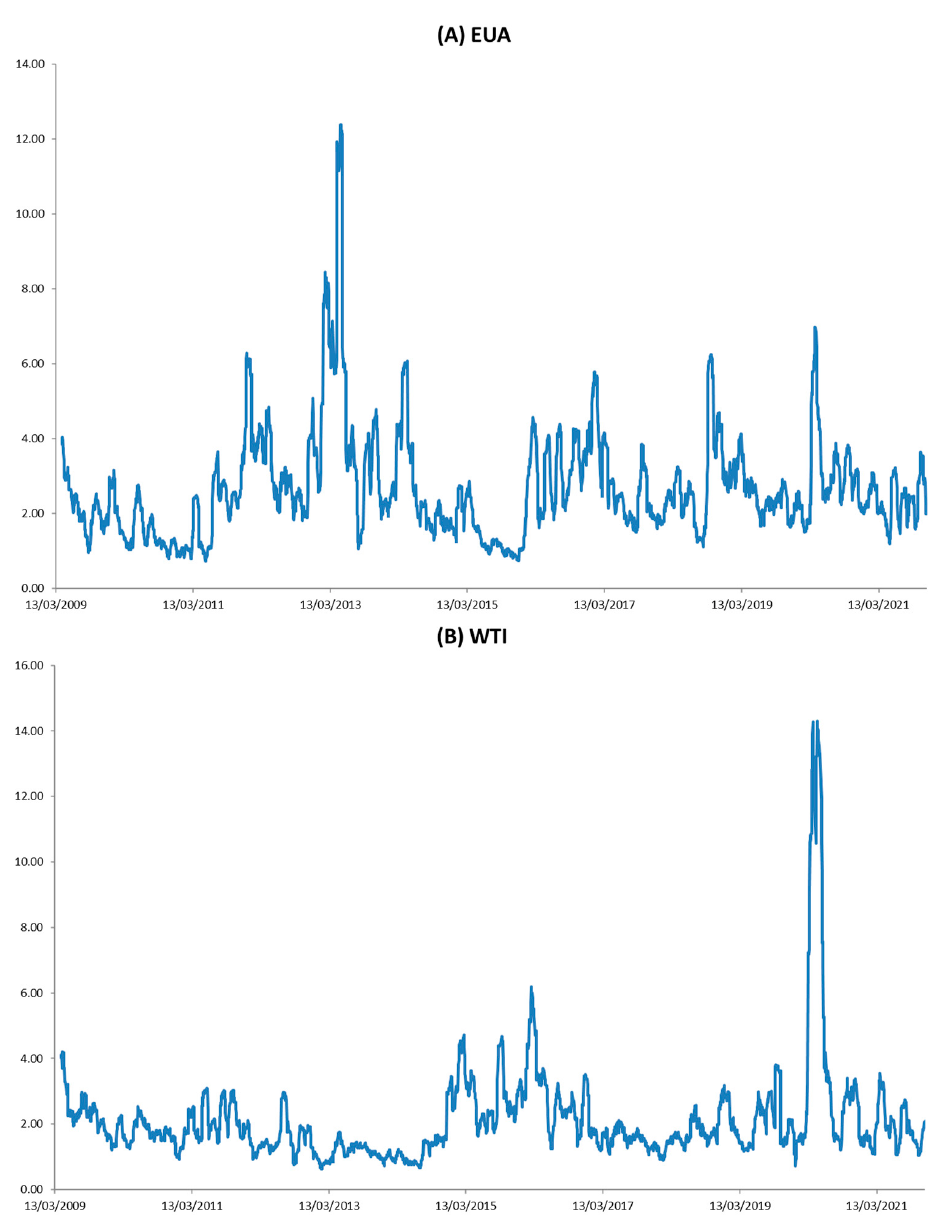
Figure 1. Return rates on EUA carbon price and WTI crude oil price.